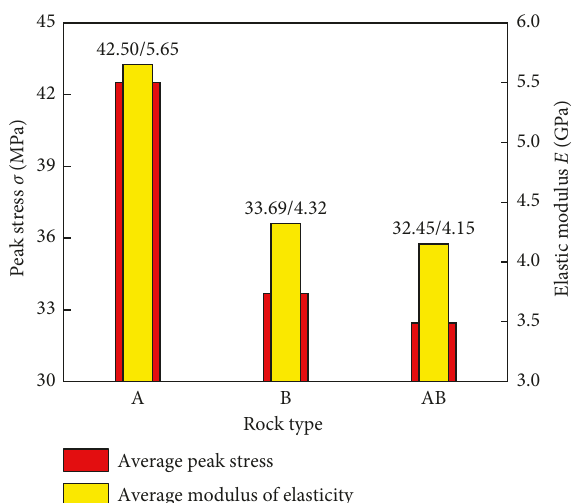
Figure 7: Average peak strength and elastic modulus of rock.